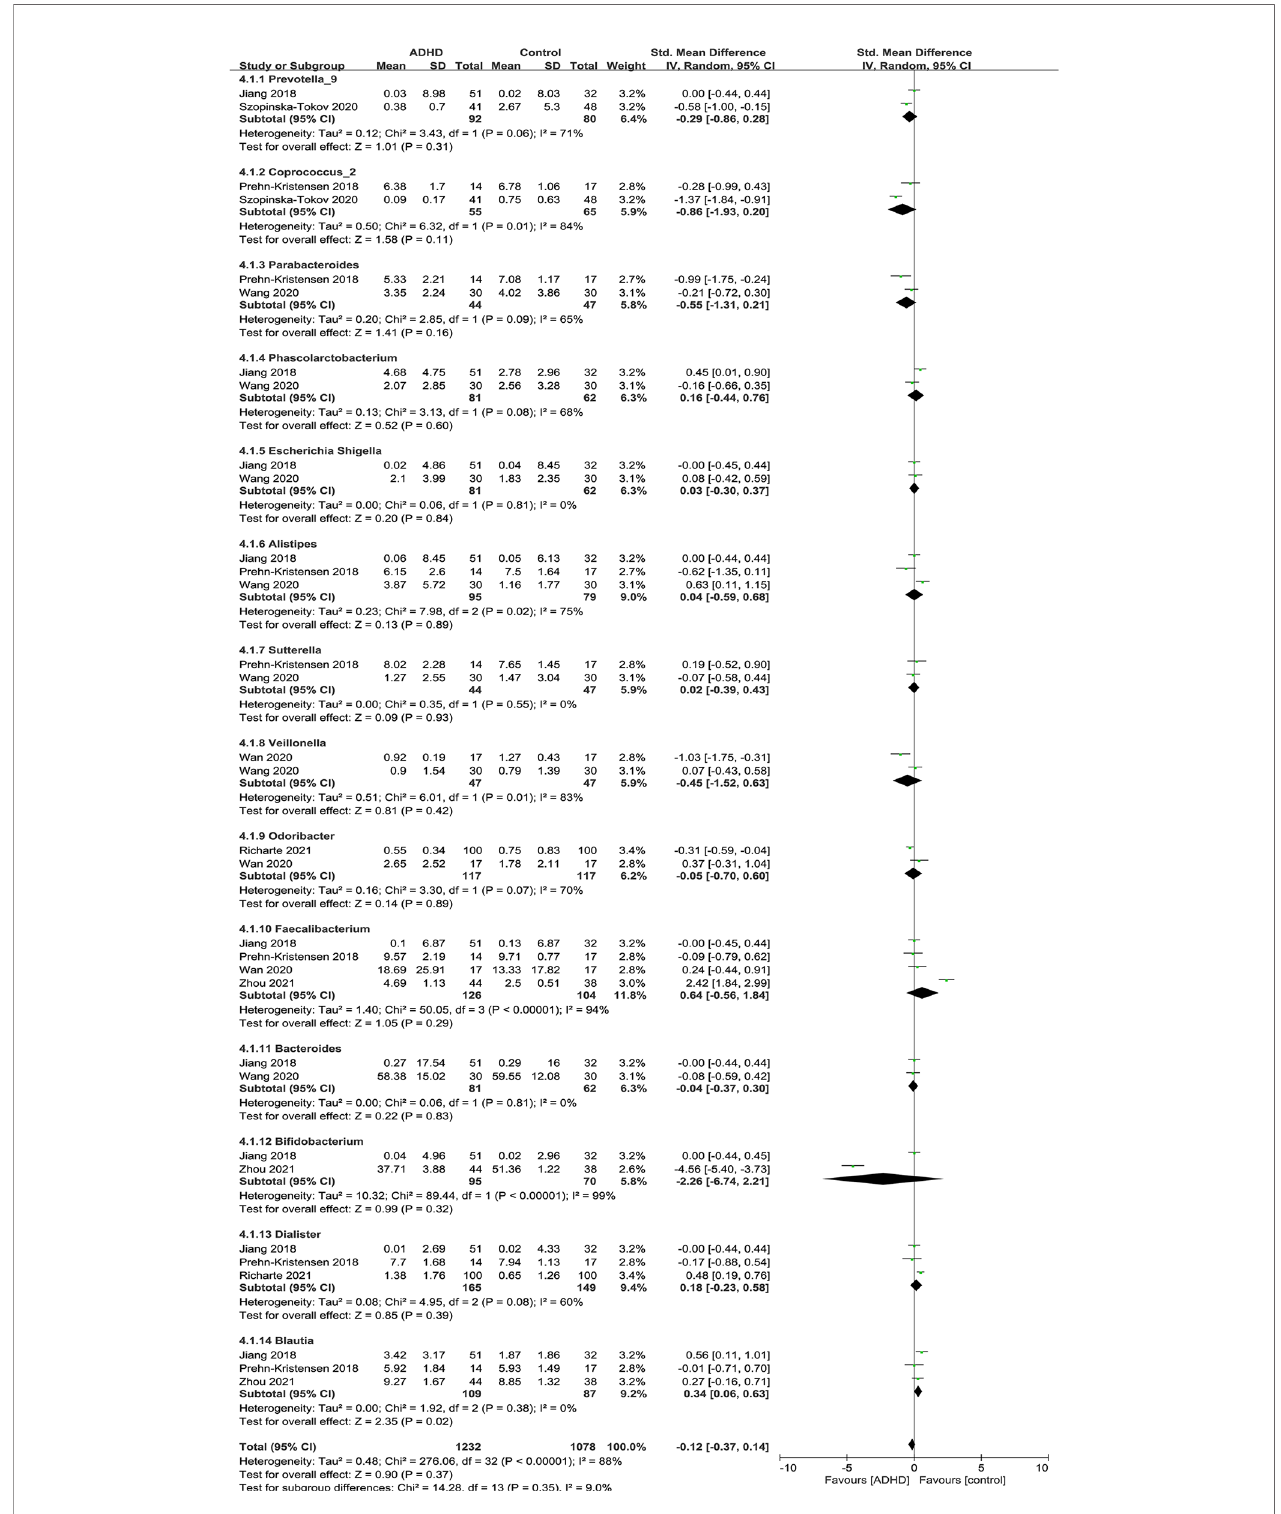
FIGURE 8 | Forest plot of relative abundance of Genus in the Gut Microbiota of ADHD Compared with HCs. CI, con fi dence interval; SMD, standardized mean difference.